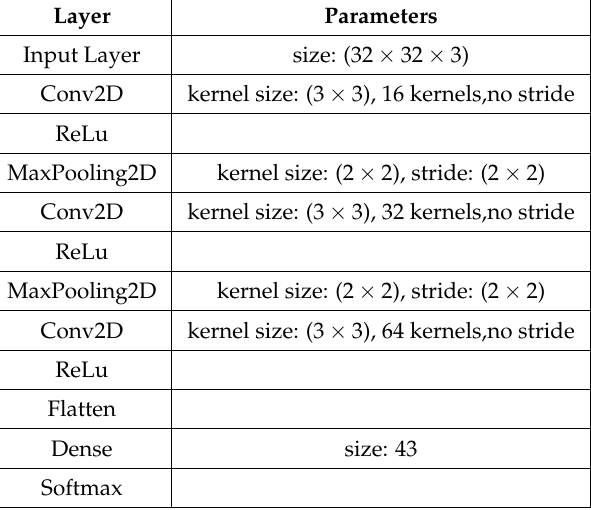
Table A4. Architecture of the used substitute NNC on GTSRB